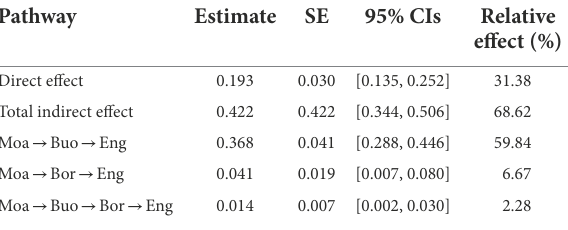
Moa = autonomous motivation; Bor = boredom; Buo = buoyancy; Eng =